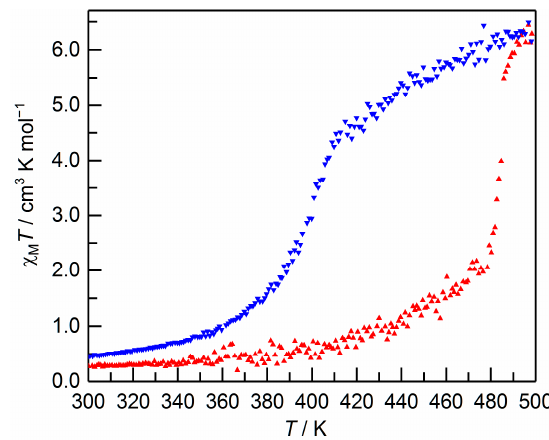
Figure 5. The magnetic behavior of 1 · AsF 6 in the form of the χ M T vs. T plots. 1 · AsF 6 was warmed from 300 to 498 K (filled triangles; red), and then cooled from 498 to 300 K (filled inverted triangles; blue) at a sweep rate of 0.5 K · min − 1 .